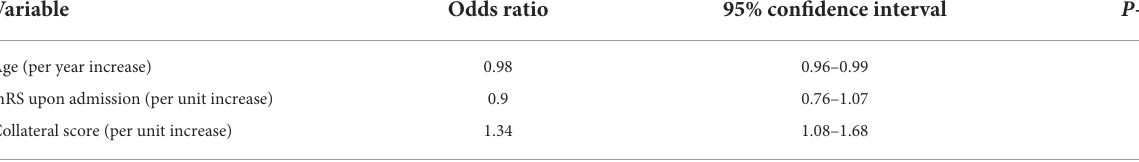
TABLE 2 Multivariate analysis for predictors of TVS.